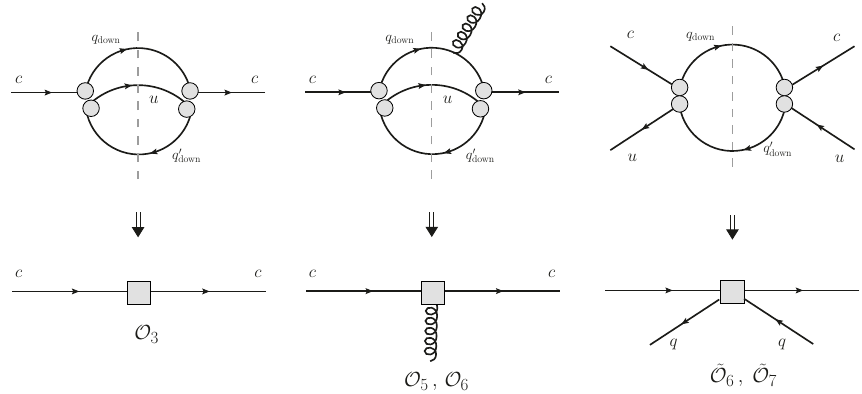
Figure 1. Representative diagrams illustrating various contributions to the inclusive width of charmed hadrons. (a) The leading contribution O . (b) higher-order “non-spectator” terms in the 3 first series, generated by insertion of covariant derivatives with respect to the background gluon field. (c) An example of a four-quark “spectator” contribution, in this case Weak exchange.